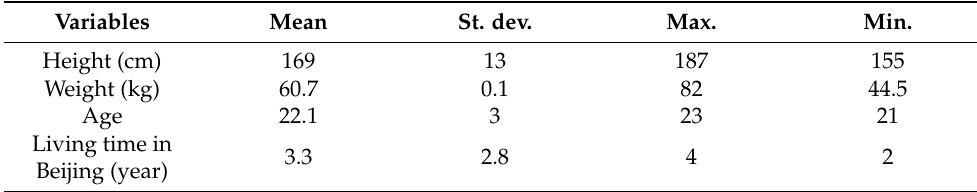
Table 1. Demographic information of participants.